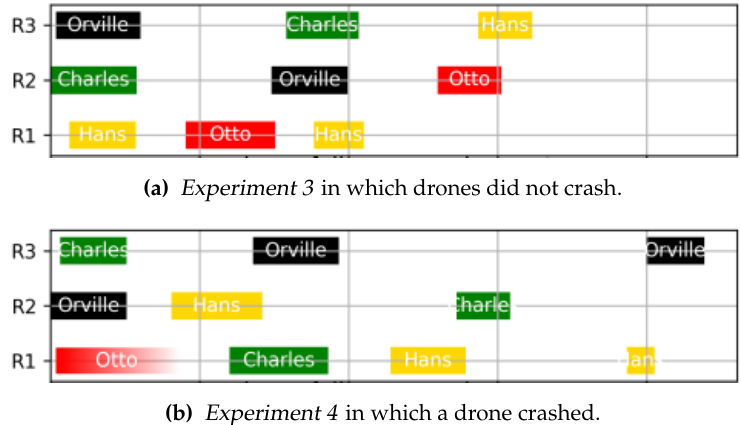
Figure 11. Assignment of regions for three different experiments. For each of the drones we represent the instant of time in which they were assigned to a region (R1, R2, or R3). We depict results for one experiment that was successfully completed ( a ), and for one experiment in which a drone crashed ( b